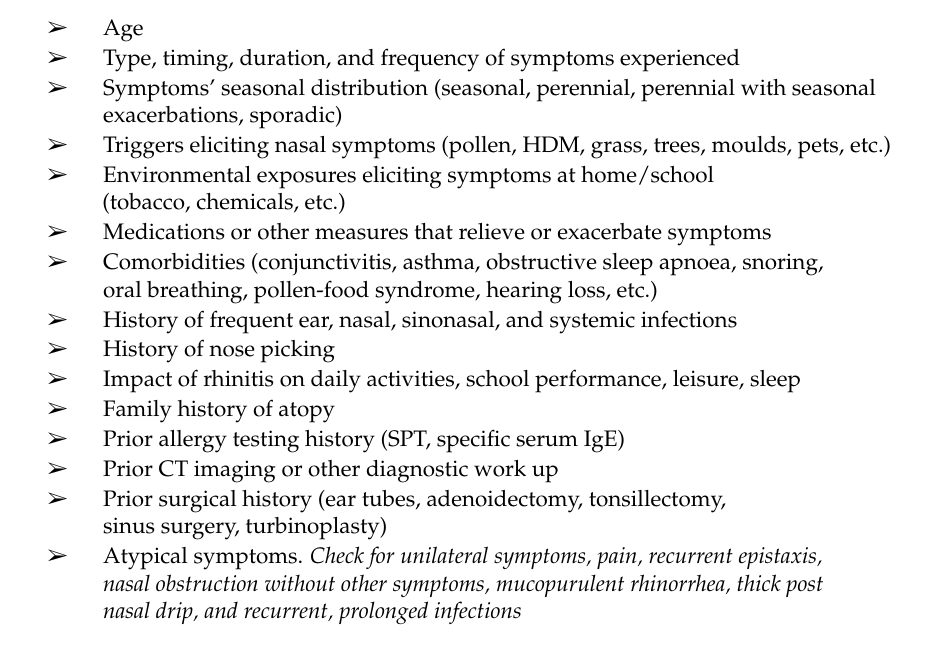
Table 2. Basic questions framework for interviewing patients with rhinitis. HDM: house dust mite; CT: computed tomography; SPT: skin prick test; IgE: immunoglobulin E.